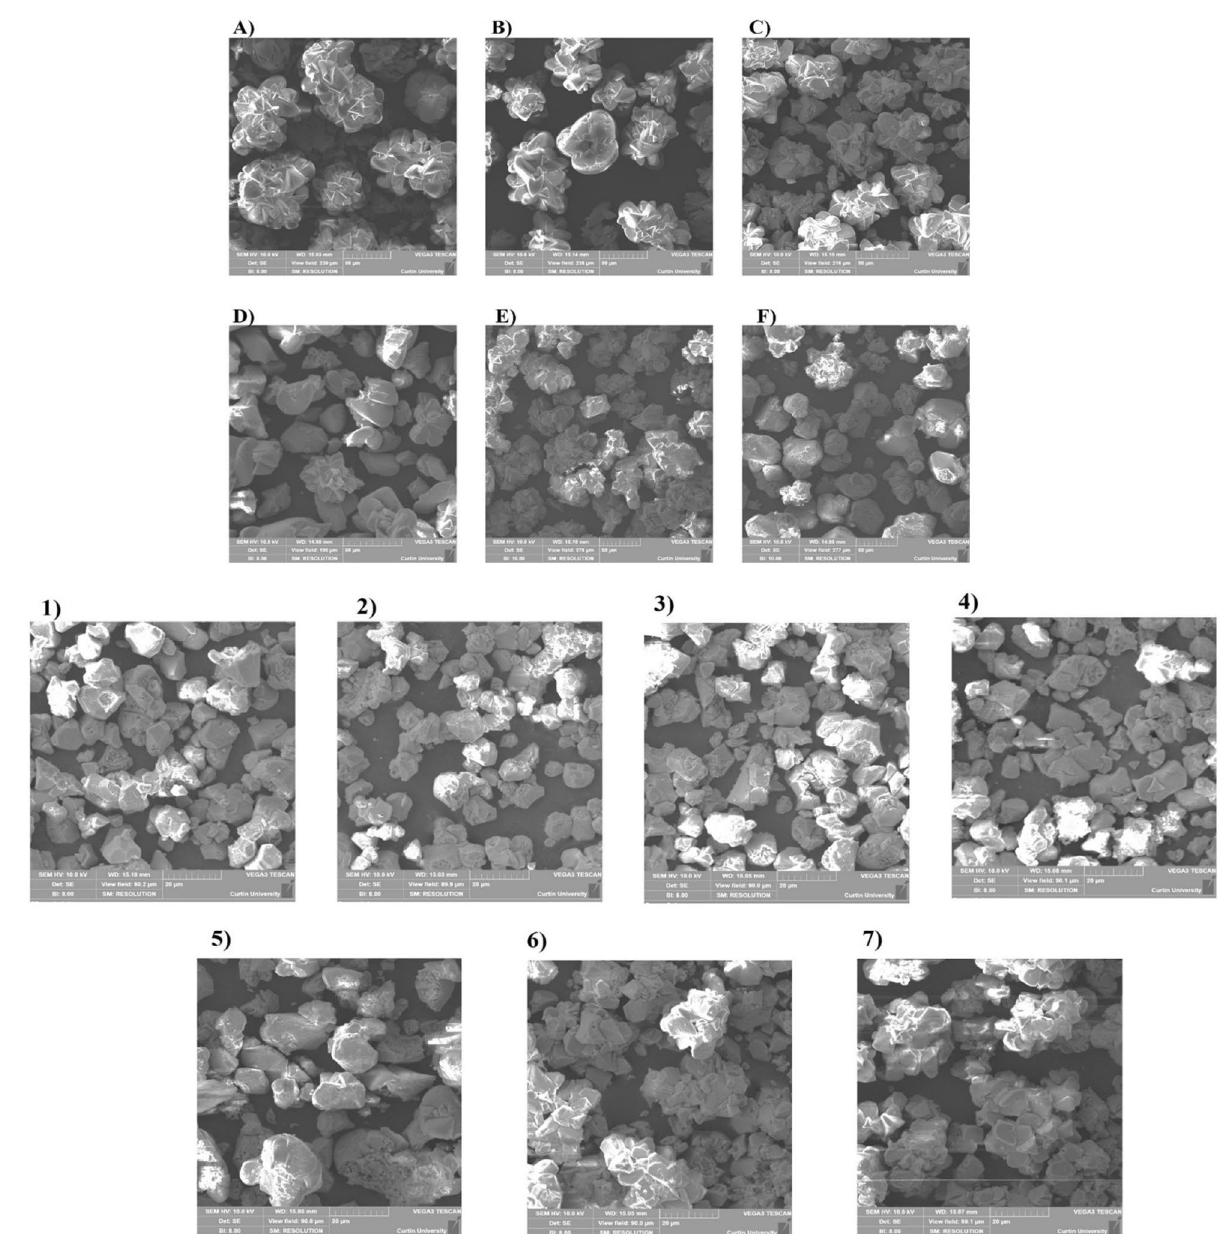
Figure 3. Scanning electron microscopy images of CaCO 3 crystals. Groups B to G (NUMC) and 1 to 7 (bioaugmentation). (B)—0.1 OD NUMC, (C)—0.2 OD NUMC, (D)—0.4 OD NUMC, (E)—0.8 OD NUMC, (F)—1.6 OD NUMC, and (G)—3.2 OD. (1)—0 OD NUMC + 0.4 OD S . pasteurii , (2)—0.1 OD NUMC + 0.4 OD S . pasteurii , (3)—0.2 OD NUMC + 0.4 OD S . pasteurii , (4) Group 4—0.4 OD NUMC + 0.4 OD S . pasteurii , (5) 0.8 OD NUMC + 0.4 OD S . pasteurii , (6) 1.6 OD NUMC + 0.4 OD S . pasteurii , and (7) 3.2 OD NUMC + 0.4 OD S . pasteurii . NUMC Native Ureolytic Microbial Community and bioaugmentation—(NUMC + S. pasteurii